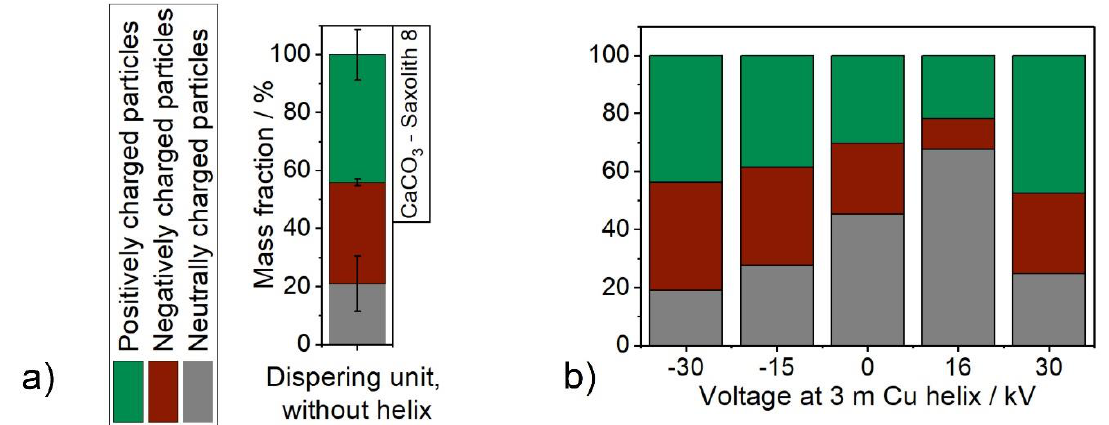
Figure 7. Charged and neutral fractions of Saxolith 8 for ( a ) no helix attached ( b ) a 3-m copper helix attached.